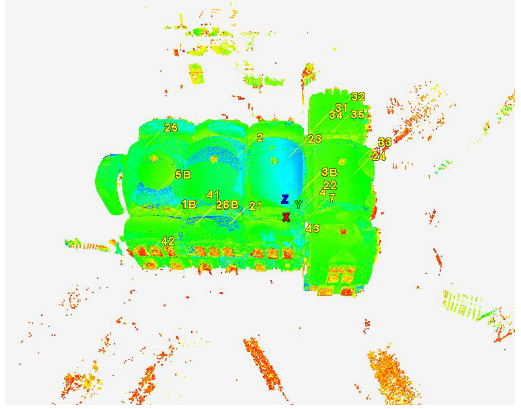
Figure 4. Point cloud resulting from registering a series of point clouds of the sygagogue interior